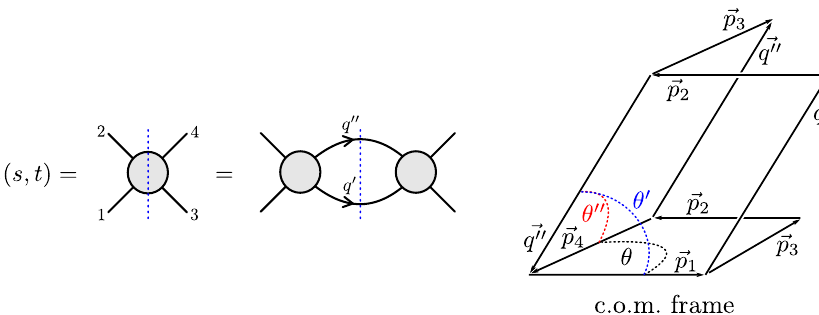
Figure 1 . In the elastic strip 4 m 2 < s < 16 m 2 the discontinuity of the amplitude comes from two intermediate particle exchange only. This result in the exact elastic unitarity equation (2.22). The corresponding phase space integration kernel P d (cos θ, cos θ 0 , cos θ 00 ) in (2.21) is proportional to a step/delta function which has a simple geometrical origin. In the center of mass frame we have three ( d − 1) -dimensional vectors, ~p 1 = − ~p 2 , ~p 3 = − ~p 4 , and ~q 0 = − ~q 00 . The geometrical angles between these three vectors, { θ, θ 0 , θ 00 } are therefore restricted to the range θ 1 + θ 2 ≥ θ 3 , where θ 1 , 2 , 3 are any permutation of { θ, θ 0 , θ 00 }